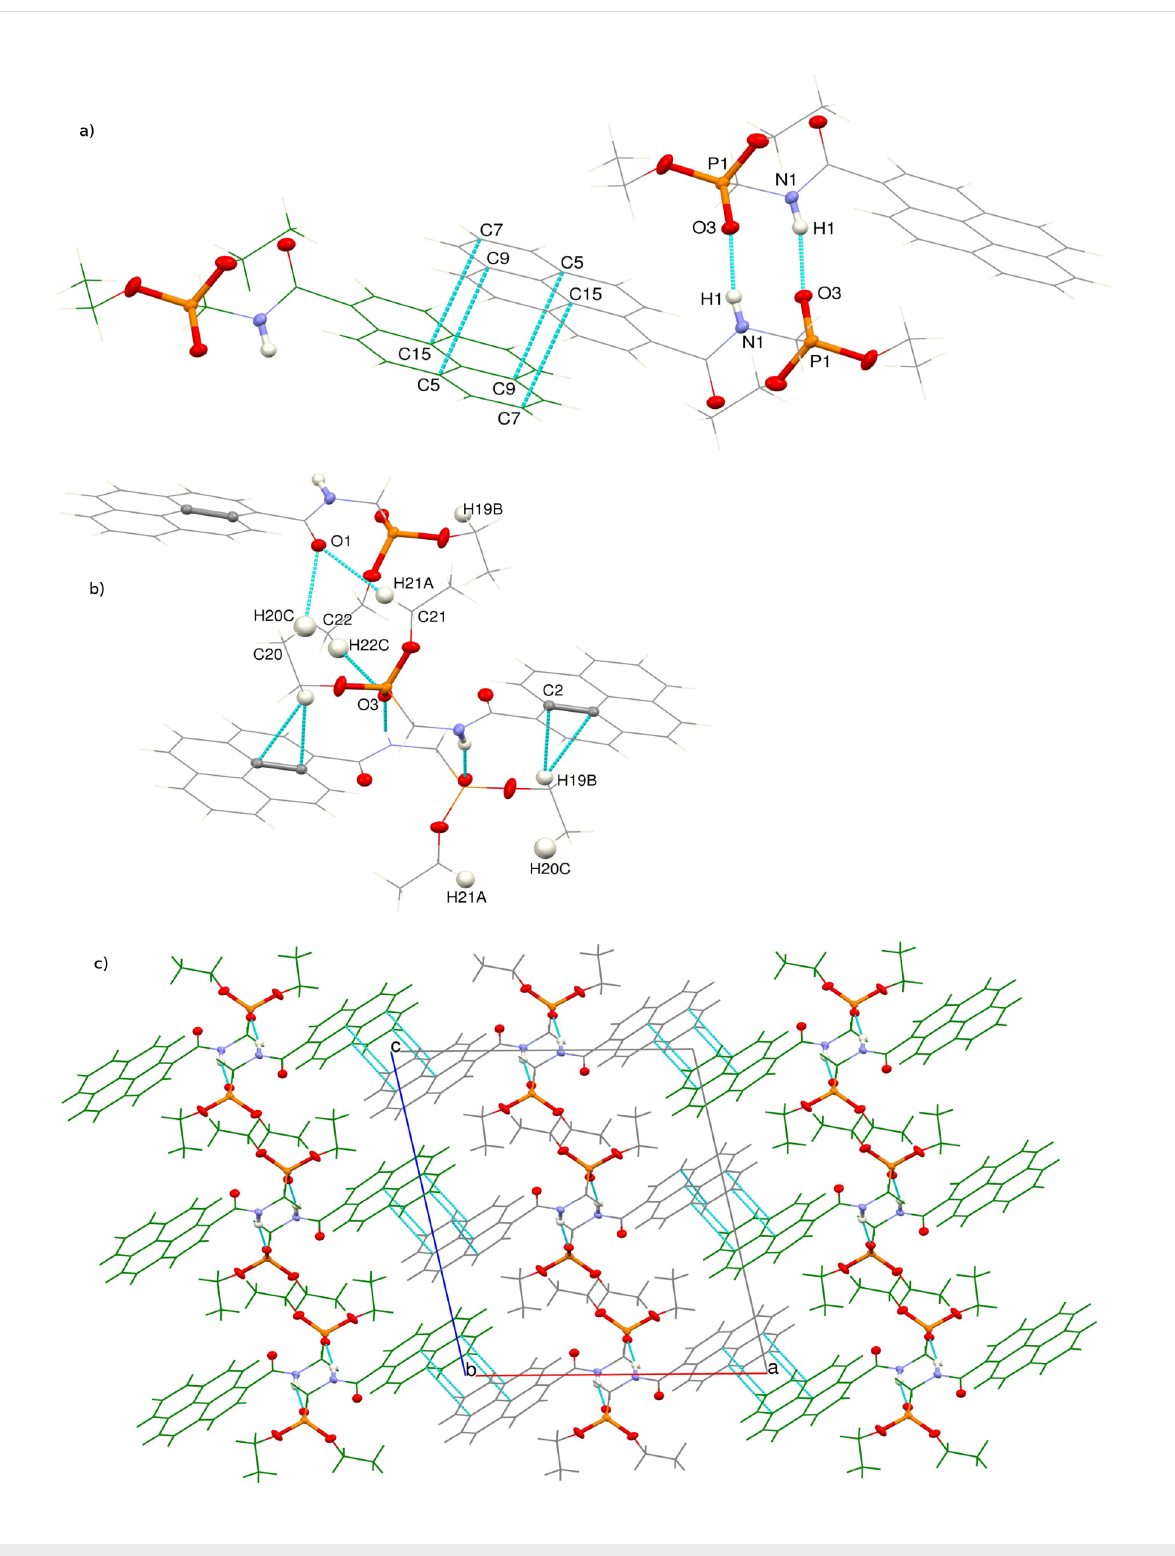
Figure 7: (a) Dimers of π -stacked and hydrogen-bonded molecules of 3a represented in single figures; (b) network of weak C–H … O and C–H … π interactions stabilizing H-bonded dimer strings and (c) crystal packing along the crystallographic b direction. Ellipsoids are drawn at 50% probability level for all non-C and non-H atoms. The remaining atoms are represented as wires in grey or green in order to differentiate between adjacent π … π interacting chains of H-bonded atoms. The shortest intermolecular contacts are represented in